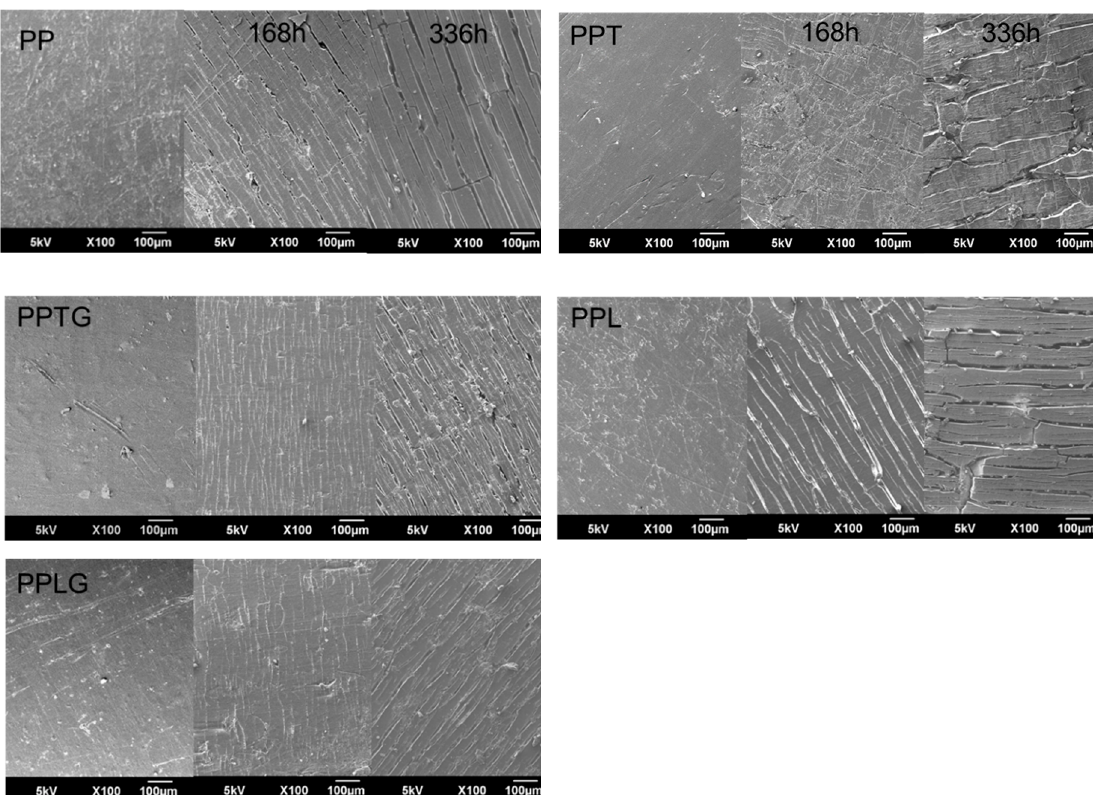
Figure 7. SEM microscopy of PP and PP/polyphenol blends over exposure time.